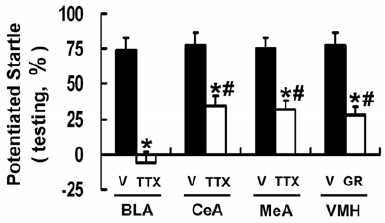
Figure 8. Pharmacological interventions showing two path- ways involved in the fear-potentiated startle. The blockers were locally injected into BLA, CeA, MeA or VMH 30 min before the training session to block local neuron activity during fear learning. *p , 0.05, blocker-treated vs. vehicle; # p , 0.05, other brain areas vs. BLA under blocker-treated conditions. GR: GR 82334 (a SP receptor antagonist),